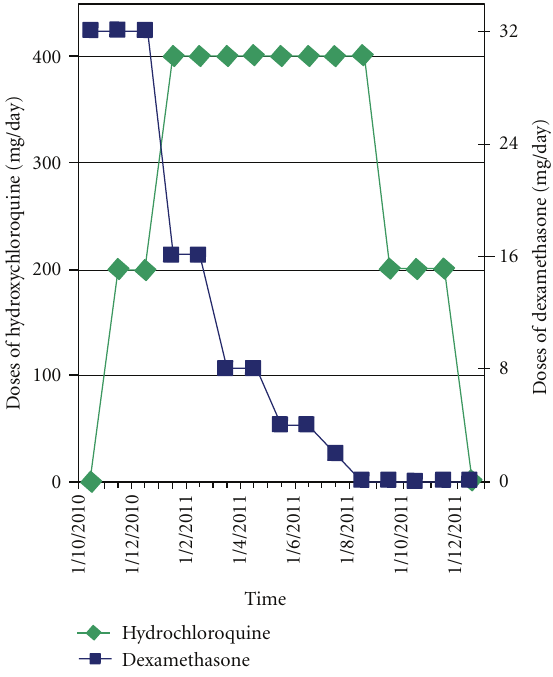
Figure 2: Medication dose versus